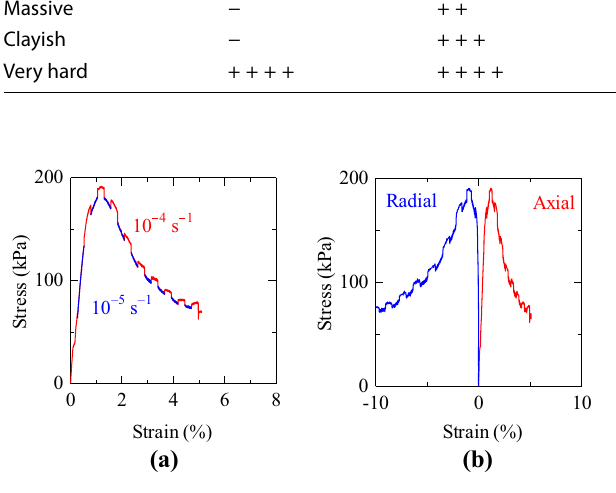
Fig. 7 Example of stress–strain curves in uniaxial compression test (os08); a digital recorded axial strain 35 and b analog recorded axial and radial